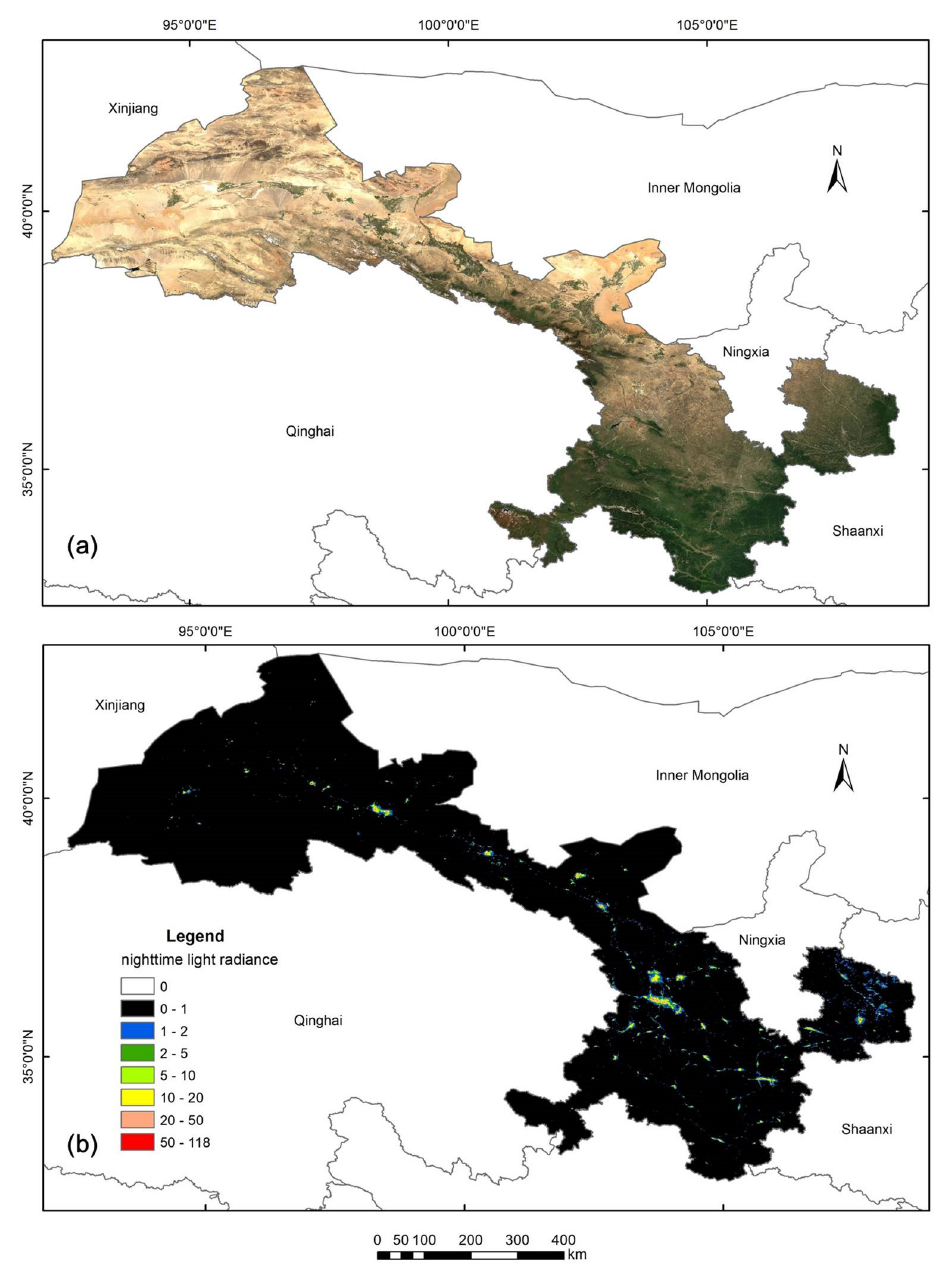
Figure 1. ( a ) The Sentinel-2 satellite true color composite image and ( b ) the VIIRS monthly average nighttime light radiance of Gansu Province.